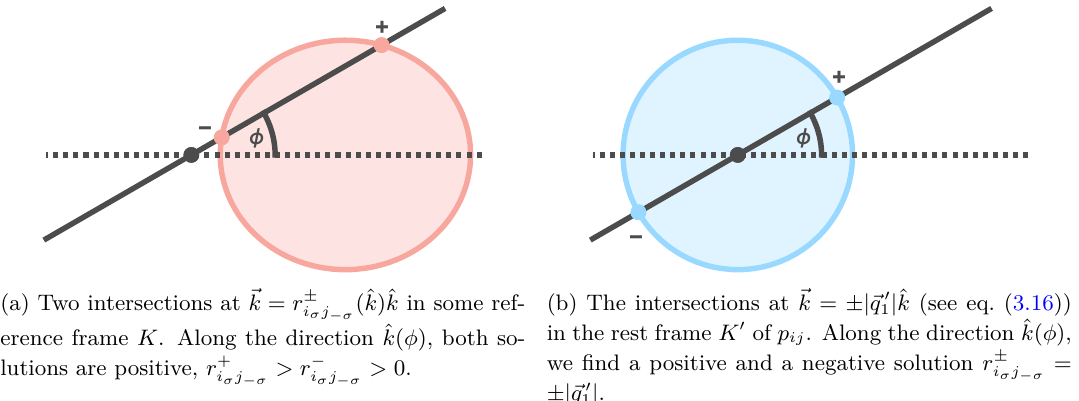
in two different reference frames K and K 0 in the spatial loop Figure 3. An E-surface E σ ij momentum space of (a) ~k = ~q and (b) ~k = ~q 0 , where K 0 is the rest frame of p i i general, the origin ~q = ~ 0 does not lie within the ellipse. However, a Lorentz boost transforms the i ellipse into a circle with center at ~q 0 = ~q 0 = ~ 0 . As a consequence, the general solutions r ± i j may both be positive or may not even be real for all directions ˆ k